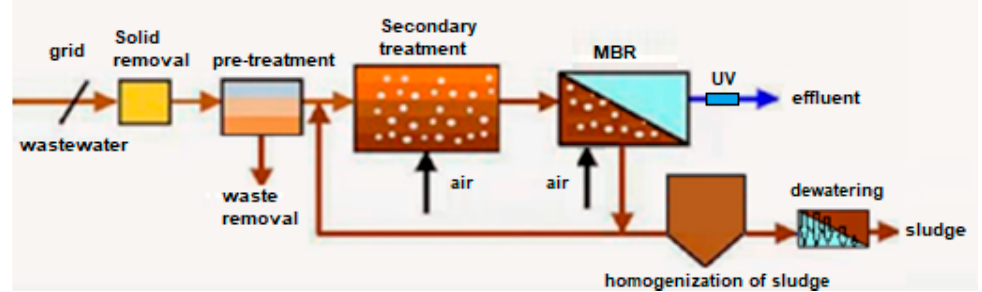
Figure 1. General purification scheme with aerobic biological reactor and membrane biological reactor WWTP A and WWTP B [15].